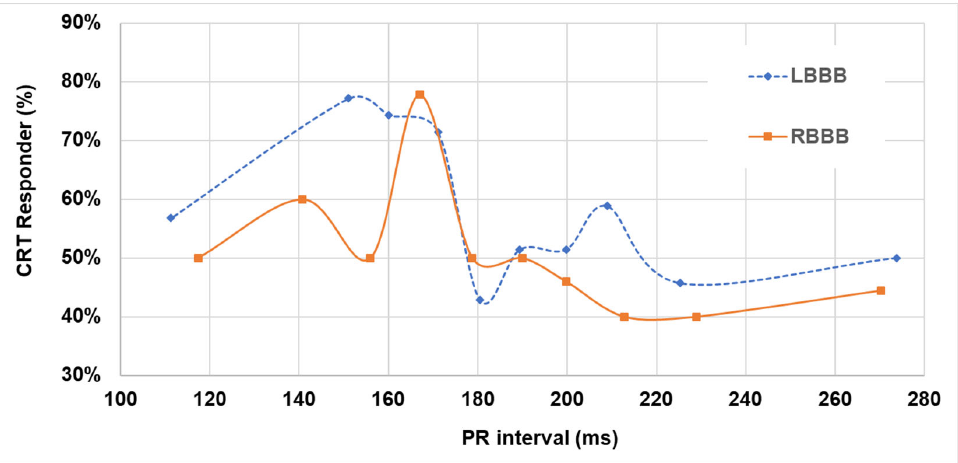
Figure 2. CRT response as a function of the PR interval according to QRS morphology . Table 2. Univariate and multivariate analysis of predictors of CRT response.